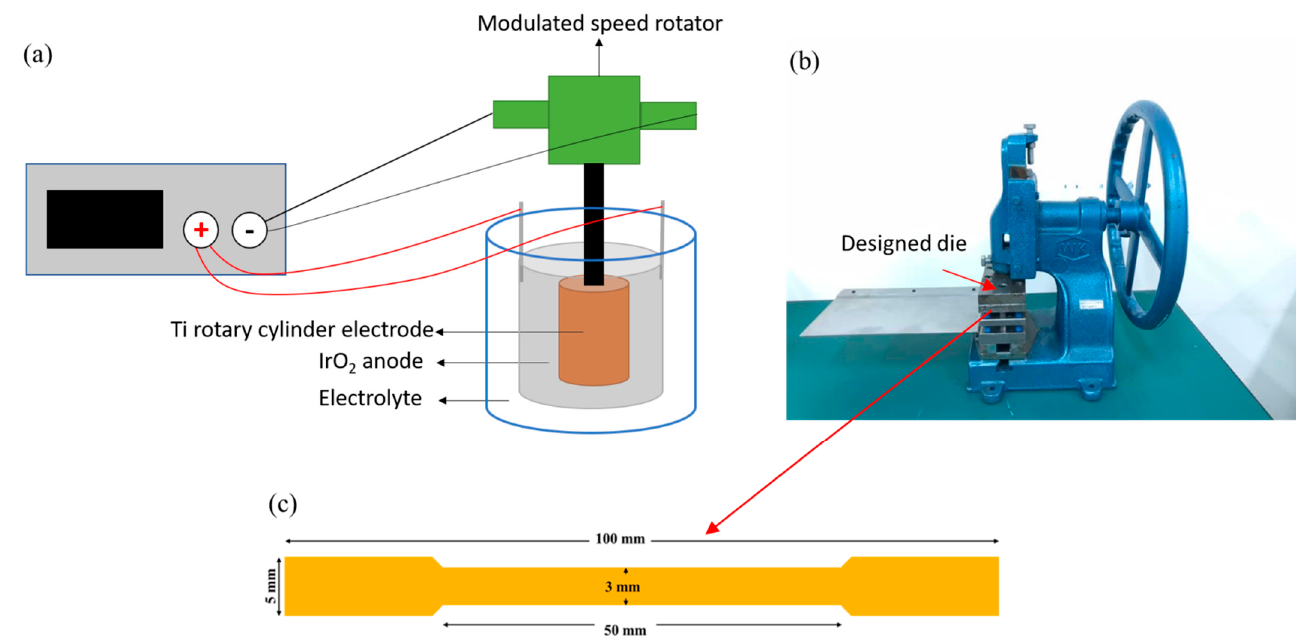
Figure 1. ( a ) Schematic of the rotary system. ( b ) The punching machine and ( c ) detailed dimensions of the nt-Cu dog-bone-shaped samples.